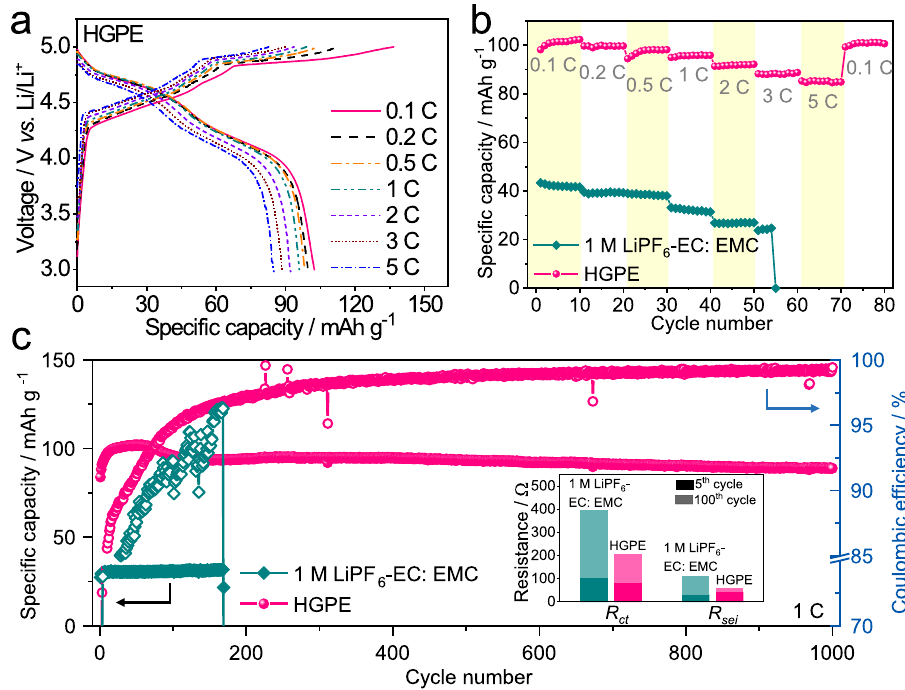
Fig. 5 Electrochemical energy storage performance of the Li | |KS6 graphite batteries. a The charge-discharge voltage pro fi les and b Rate performances of a Li|HGPE| KS6 graphite cells employing 1 M LiPF 6 -EC: EMC and HGPE under different C rates. c Long-term cycling performance Li | |KS6 graphite cells at 1 C (1 C = 100 mA g − 1 based on the mass of graphite). The corresponding R sei / R ct changes during cycling are shown in the